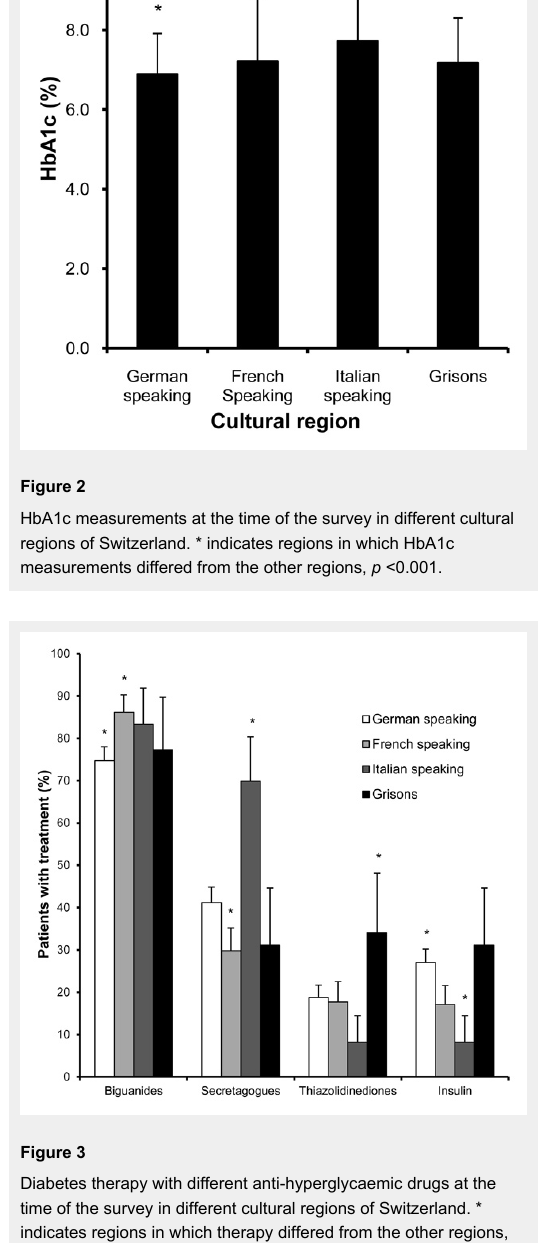
Changes (%) in BMI, fasting glucose, HbA1c and serum lipids at the time of the survey compared to the retrospective survey, in different cultural regions of